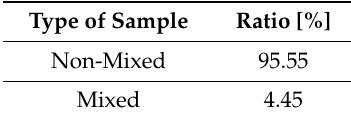
Table 2. Percentage of non-mixed and mixed